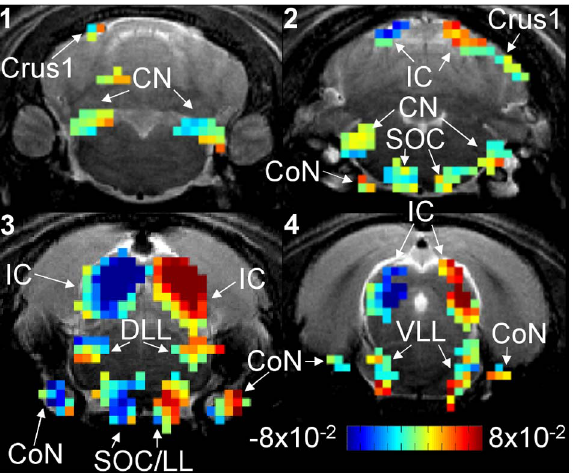
Figure 4. BOLD signal ratio slope map. BOLD signal ratio slope map computed (refer to methods for computation details) from the animal in Figs. 2 and 3. Slope is color coded from 2 8 6 10 2 2 %/dB to 8 6 10 2 2 %/dB and only activated voxels in Fig. 2 are color coded. Positive slope indicates the signal is greater at positive ILDs or when left ear SPL is greater than right ear SPL. Similarly, negative slope indicates the signal is greater at negative ILDs. Negative slope voxels are located in the left hemisphere CoN, SOC/LL, DLL, and IC and the right hemisphere CN. Positive slope voxels are located in the right hemisphere CoN, SOC/LL, DLL, and IC and left hemisphere